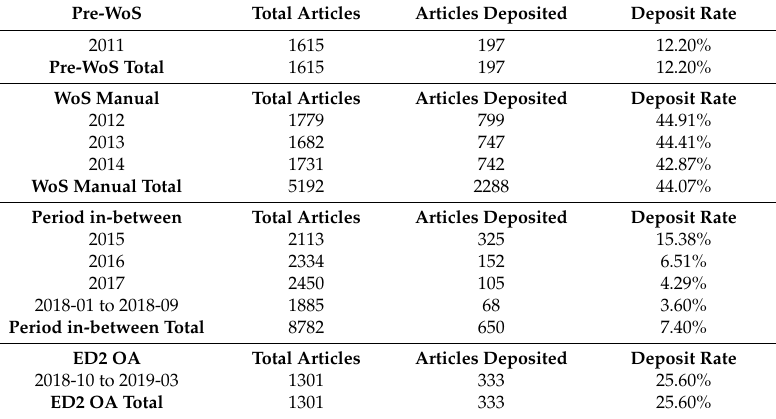
Articles Deposited Deposit Rate